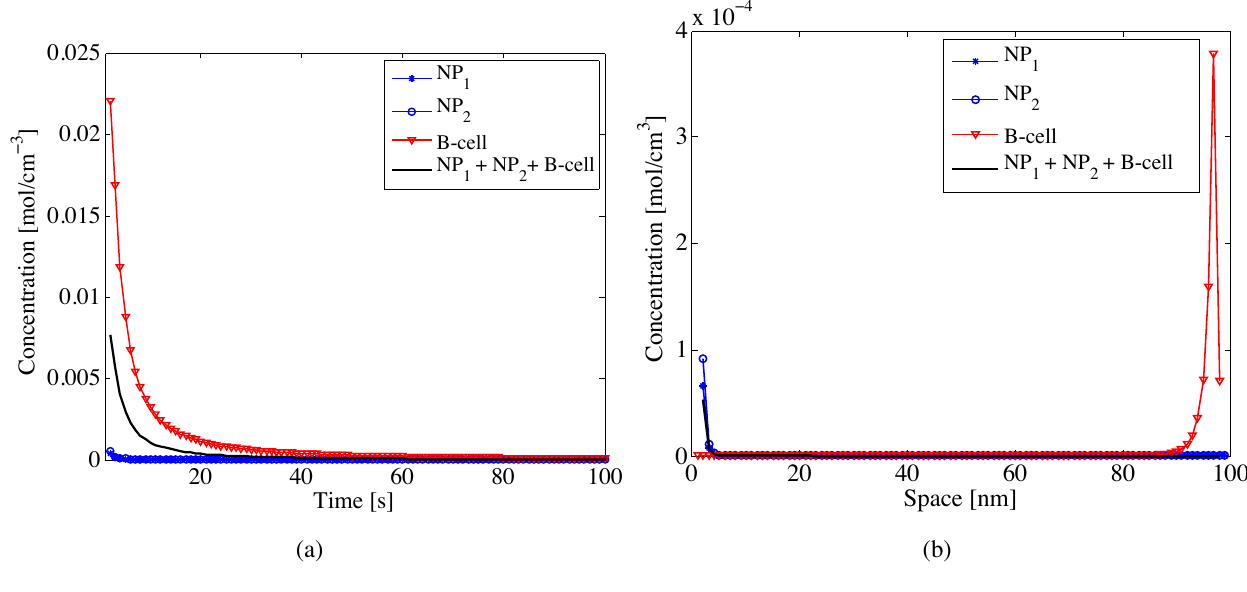
Figure 4. Variation of nanoparticles and B-cell concentrations, vs . ( a ) time and ( b ) space for different values of initial diffusion coefficients i.e. , 1 . 41 × 10 3 (nm 2 /s) for NP 1 . 13 × 10 3 (nm 2 /s) for NP and 16 . 16 (nm 2 /s) for B-cells. The superposition effect provides 2 the average concentration due to the interaction among two flows of nanoparticles and the B-cells ( i.e. , NP + NP + 1 2